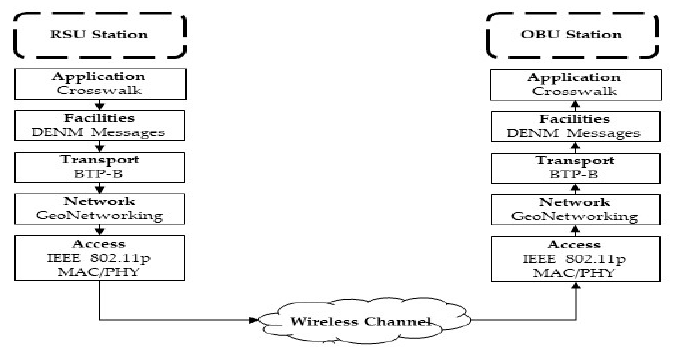
Figure 8. End-to-end ITS-G5 protocol stack for DENM messages.